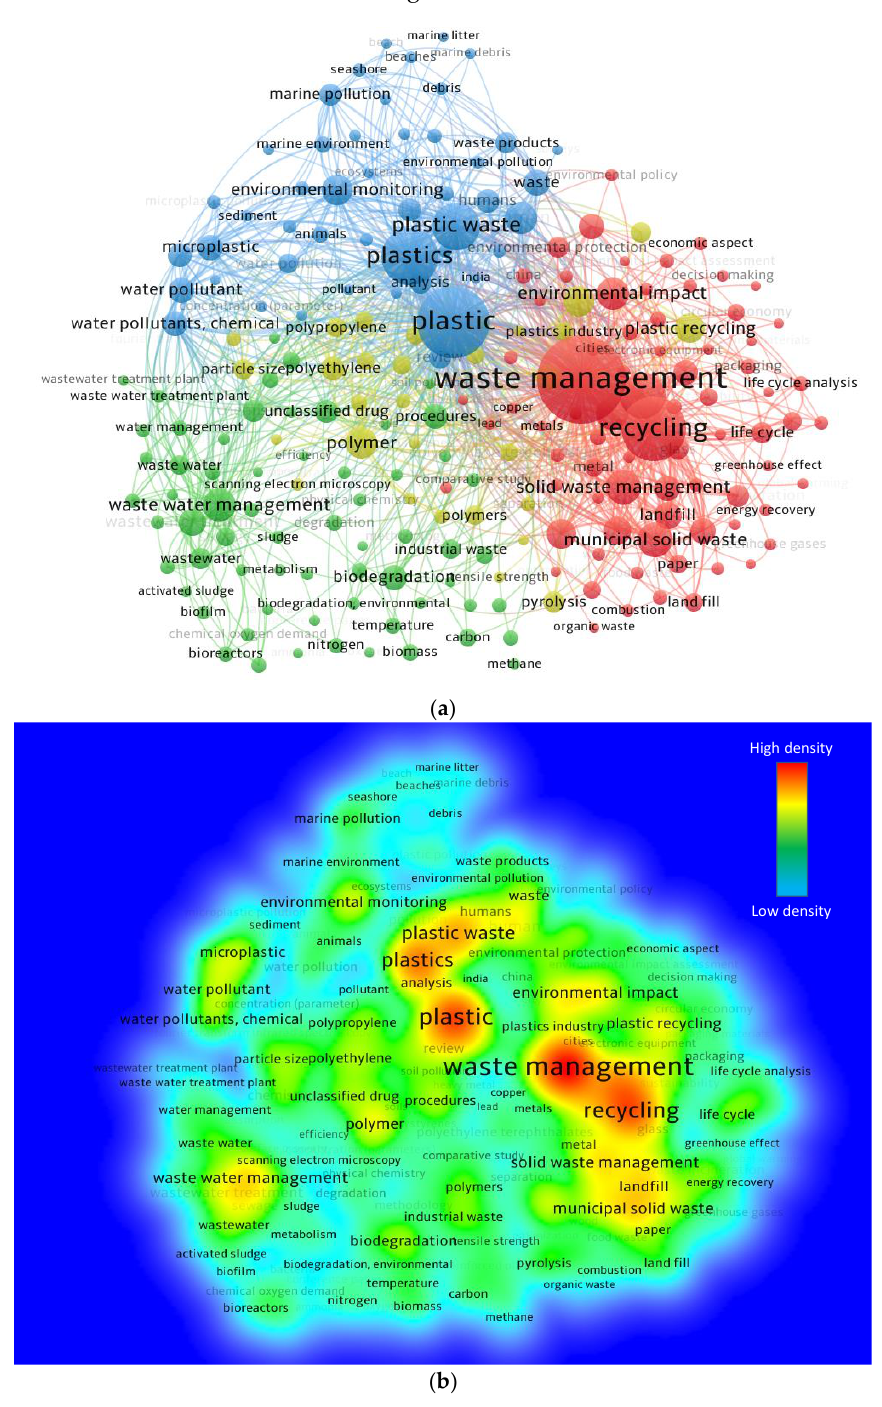
Figure 7. Co-occurrence of keywords: ( a ) Scientific mapping: circle size is proportional to the number of co-occurrences of a particular keyword; different colors show distinct clusters (red: cluster 1, green: cluster 2, blue: cluster 3, and yellow: cluster 4), and clustering by color is based on patterns of co-occurrence among multiple keywords in the published articles; ( b ) Density mapping.